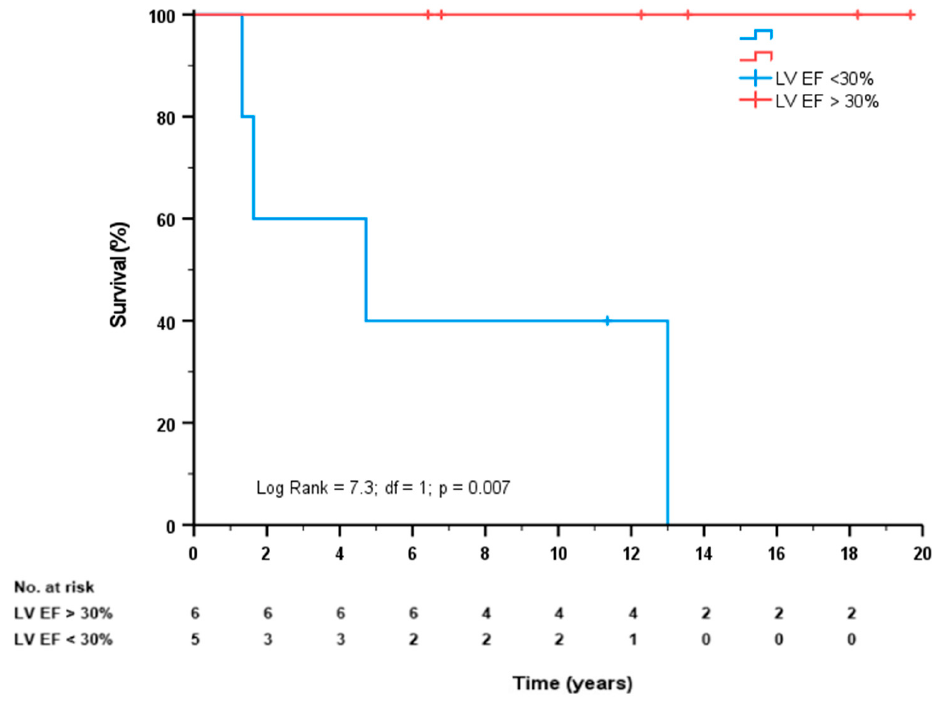
Figure 2. Survival curves for patients with mild to moderate LV dysfunction (LV EF > 30%) (red or severe LV dysfunction (LV EF < 30%) (blue line) or severe LV dysfunction (LV EF < 30%) (blue line).